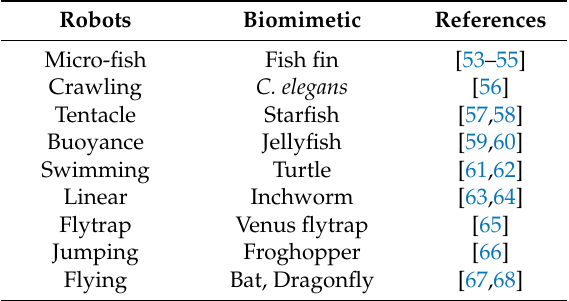
Table 3. Summary of state-of-the-art bio-inspired robotic applications using SMA